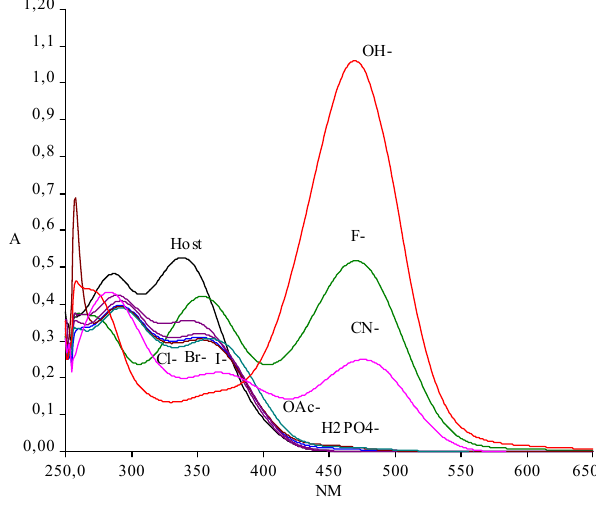
− , OH − , CN − ) at 1:1 ratio in DMSO PO 2 4